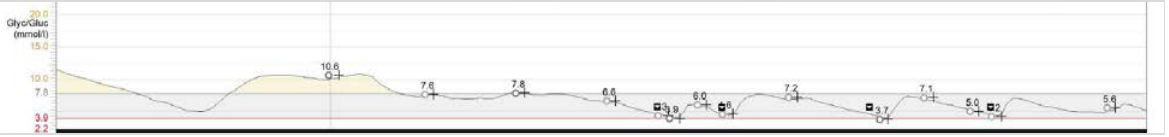
Figure 4: Continuous glucose monitoring during a day of fasting and pump therapy. Plus sign = calibration; inverted triangle = ALERT.